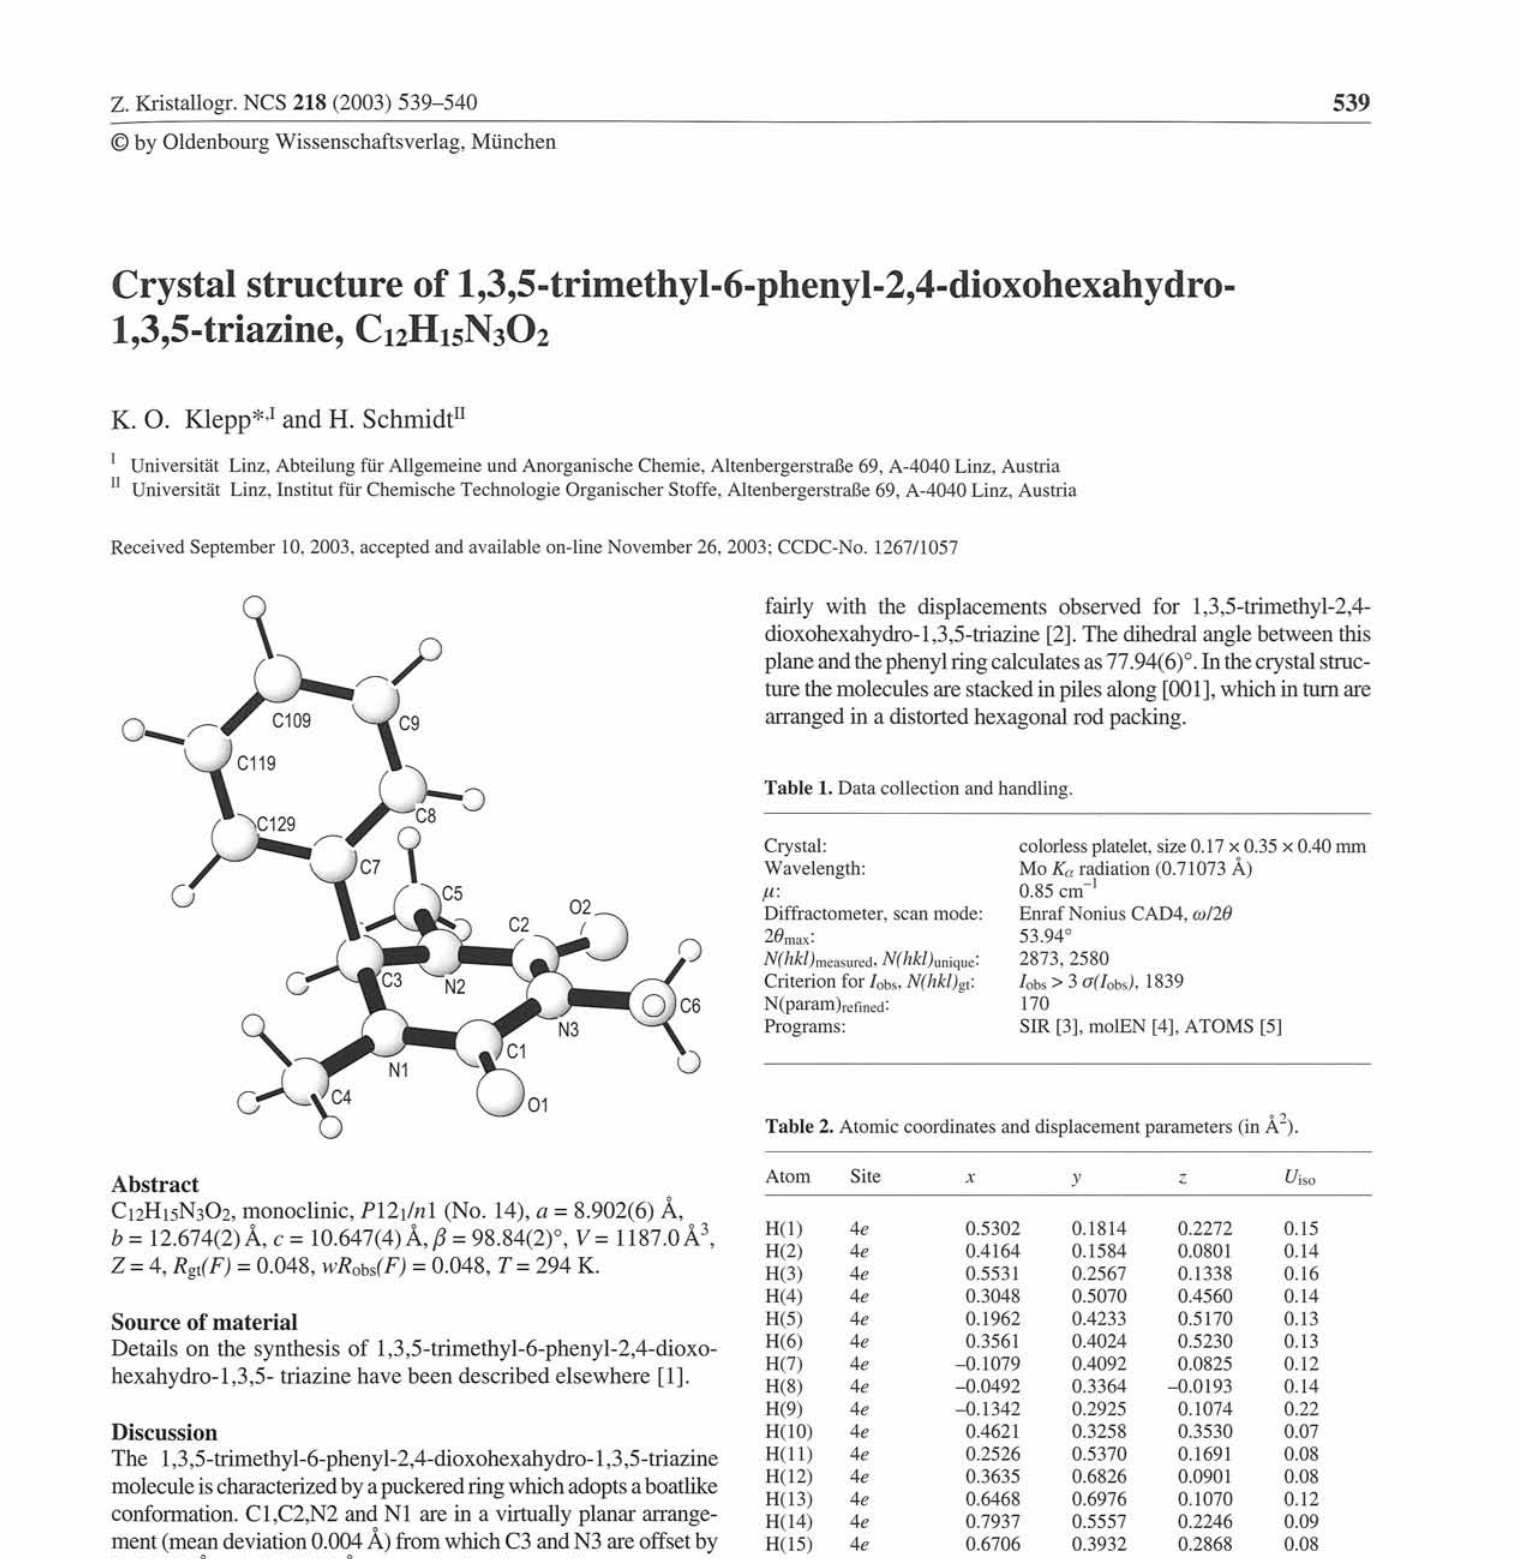
Table 3. Atomic coordinates and displacement parameters (in A 2 ).